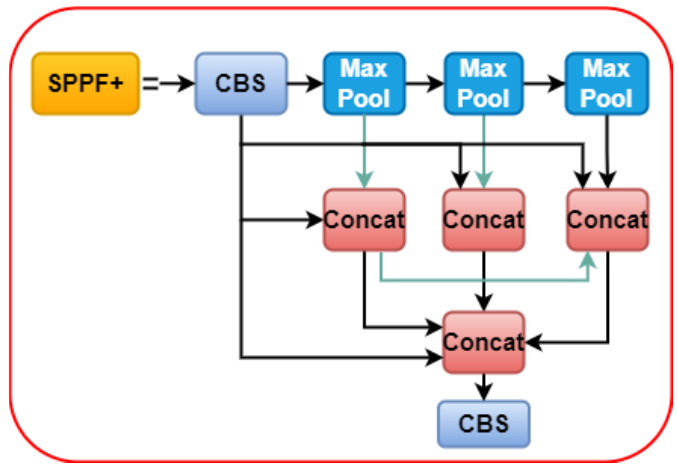
Figure 5. The flowchart of spatial pyramid pooling fast+.